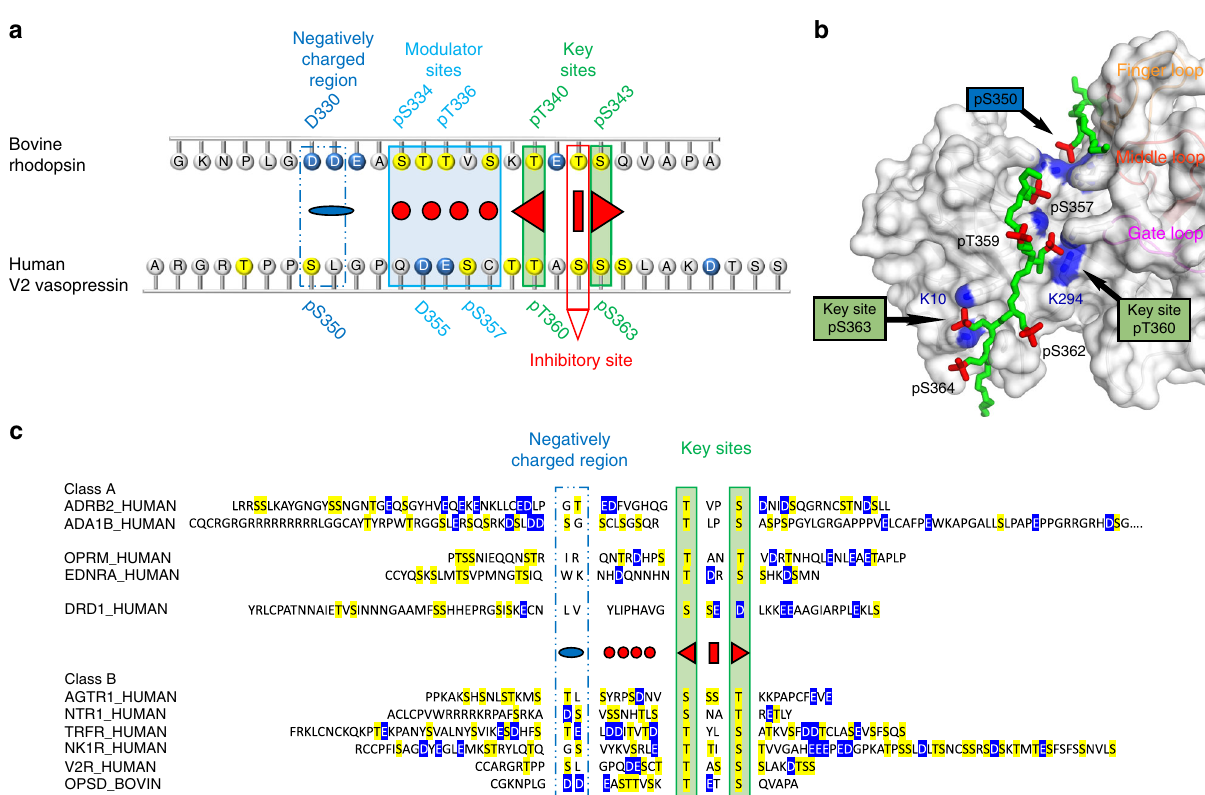
Fig. 8 Phosphorylation motifs within the larger family of GPCRs. a The three functionally distinct phosphorylation motifs described in this study are illustrated on aligned C-termini from two class B GPCRs. Negatively charged amino acids are colored blue and potential phosphorylation sites are colored yellow. b Crystal structure of the fully phosphorylated C-terminus of the class B GPCR V2 vasopressin receptor (V2Rpp, green stick model with phosphorylation sites highlighted in red) bound to arrestin-2 (gray surface model) (PDB accession 4JQI) 37 . Important interactions between certain phosphate groups on the peptide (red) and basic residues on arrestin-2 (blue patches) are indicated (see main text for details). c Sequence alignments of receptor C-termini from class A and class B GPCRs. All serines and threonines (possible sites of phosphorylation by the GPCR kinases) are highlighted in yellow. Negatively charged residues are highlighted in blue. The sequences are aligned based on the key site motif (serine or threonine residues separated by two amino acids, green box) and the negatively charged motif (two acidic or one phosphorylatable serine or threonine residues 8 residues upstream of the closest activator site, blue box). The alignment indicates that all class B receptors (strong arrestin binders) contain both the key sites and the negatively charged motif. In contrast, class A receptors (weak arrestin binders) generally lack the negatively charged motif (see Supplementary Note 1 for a more detailed